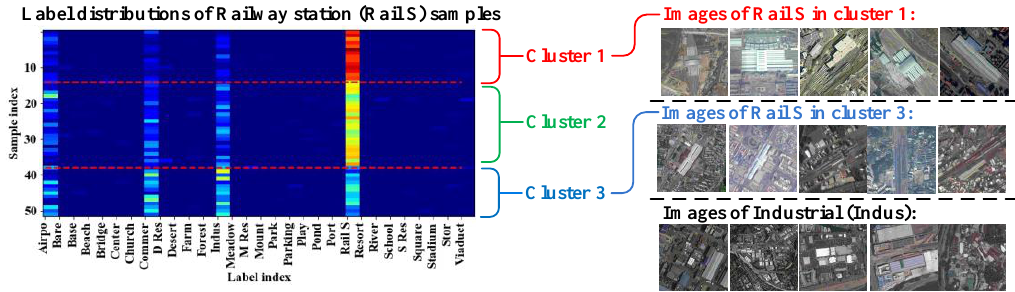
Figure 6. Grouped label distributions of Rail S samples. At the left, each row represents the label distribution of a sample. At the right, we present the images of which the label distributions near the corresponding cluster centers.